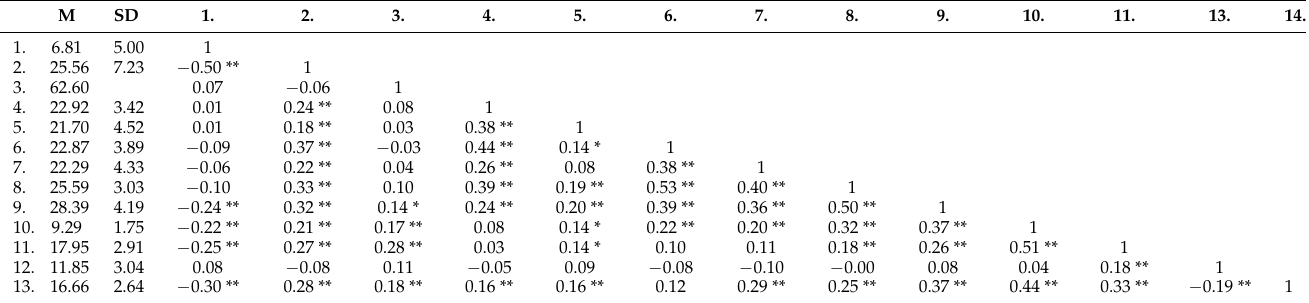
Table 1. Descriptive correlational